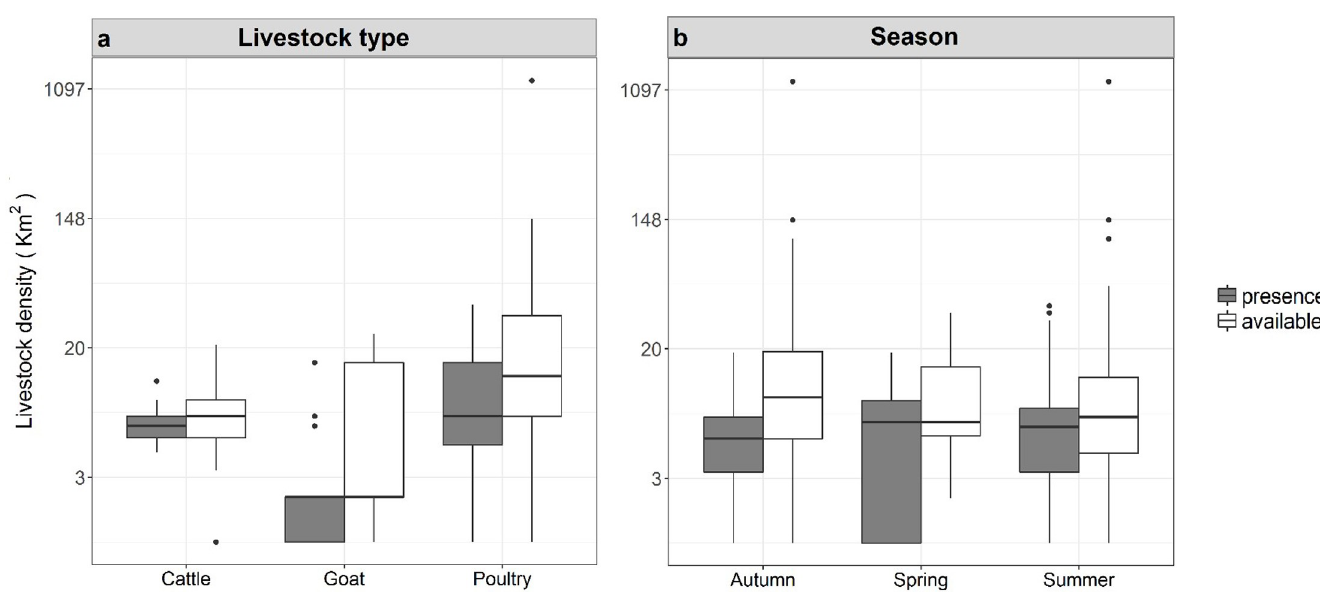
Fig 2. The presence and availability data for the Waterberg wild dog pack in a) areas with different livestock type (cattle, goats and poultry) densities (per km2) and presence and availability data across b) different seasons in Limpopo Province, South Africa. Boxplots show medians (dark horizontal bars), 1st and 3rd interquartiles (boxes), 95% CI (whiskers) and outliers (dots). Presence data are indicated by coloured boxes.